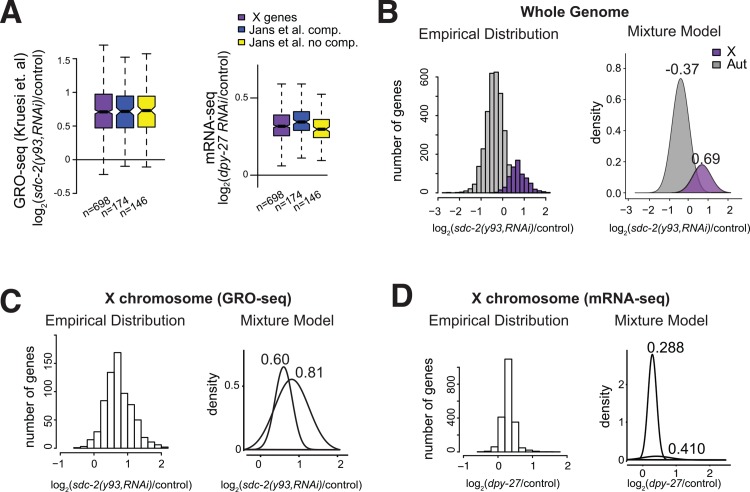
DCC-mediated transcriptional repression is applied continuously across the X chromosomal genes.(A) Box plots show the distribution of GRO-seq gene-body log2 ratios in sdc-2(y93,RNAi) versus control mixed stage embryos taken from published data [43]. Dosage compensated (blue) and non-compensated (yellow) genes were previously categorized by microarray experiments [42]. On average, previously designated compensated and noncompensated classes showed similar upregulation of transcription upon sdc-2(y93,RNAi) treatment. Same analysis was performed using mRNA-seq data comparing dpy-27 versus control RNAi in mixed embryos. In this case, noncompensated classes showed less upregulation measured by mRNA-seq. (B) A mixture model was used to represent the presence of subpopulations within an overall population, and applied to the GRO-seq expression ratios of all measured genes. This model identified two distributions similar to the empirical X and autosomal distributions. Values above modeled distributions show the mean for each distribution. (C, D) Same mixture model approach was used to analyze subpopulations within only the X chromosome using the GRO-seq (C), and dpy-27(y56) mRNA-seq (D) data in mixed embryos. Both subpopulations showed upregulation, thus the effect of the DCC appears continuous such that no large distinct class of genes completely escapes DCC regulation.